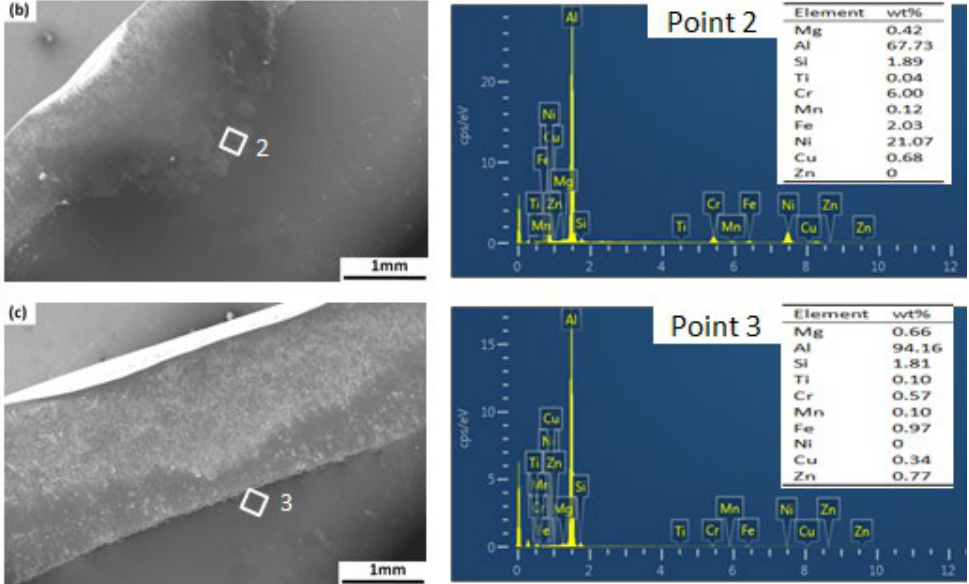
Figure 9. Cross-sectional morphology and EDS analysis for different coating thicknesses: ( a ) 0.5 mm; ( b ) 1 mm; ( c ) 1.5 mm.